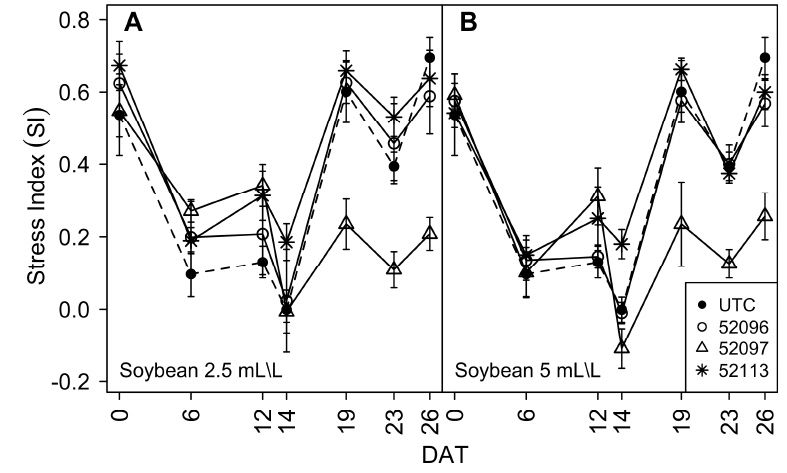
Figure 3. Mean values ± SE ( n = 5) of Stress Index (SI) measured on ( A ) soybean plants treated at lower dosage, ( B ) soybean plants treated at higher dosage. Dashed lines and filled black circles ( ● ) identify the untreated control plants (UTC).